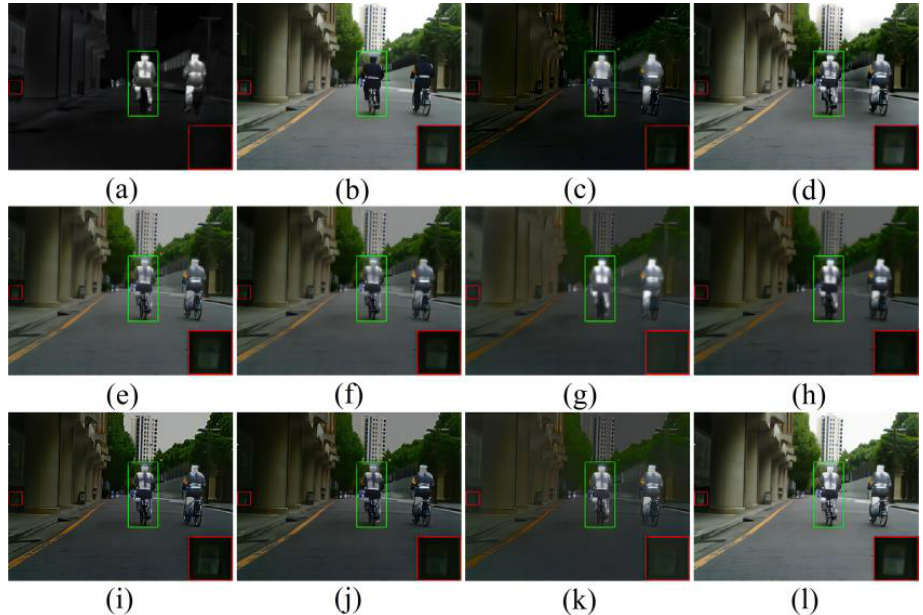
Figure 10. Comparison of 10 image fusion methods in daytime scenes. ( a ) Infrared. ( b ) Visible. ( c ) GTF. ( d ) MST-SR. ( e ) DenseFuse. ( f ) RFN-Nest. ( g ) FusionGAN. ( h ) GANMcC ( i ) IFCNN. ( j ) U2Fusion. ( k )SDNet. ( l ) SeAFusion. The green area is to highlight the fusion effect, while the red area is to highlight the fusion effect in the details.